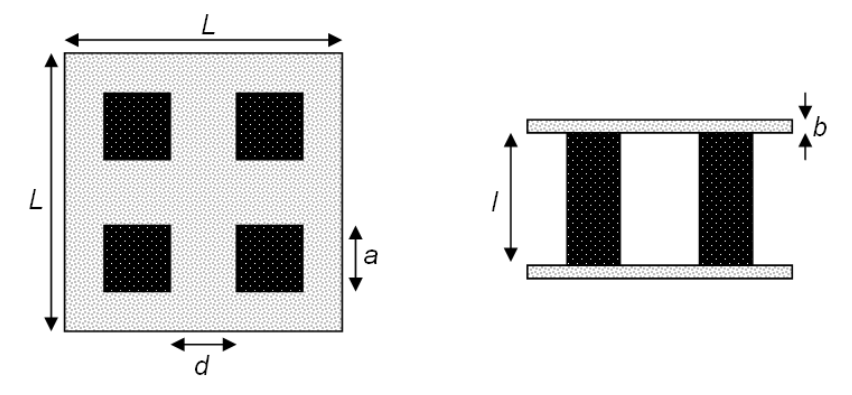
Figure 1. Top and front view of TEC